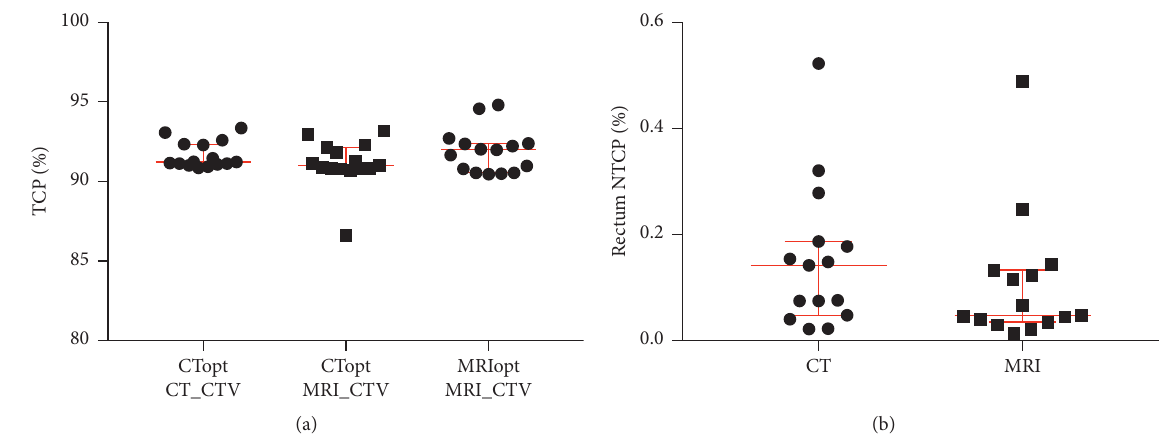
Figure 4: Comparison of TCP and NTCP for CT- versus MRI-based planning. The percent tumor control probability (a) and percent rectal complication probability (b) for CT-based and MRI-based radiotherapy planning is shown. None of the differences between groups were significant. See text for TCP group